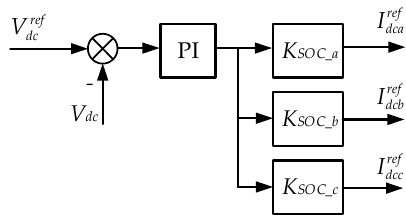
Figure 5. DC side equivalent circuit of the MMC-BESS.